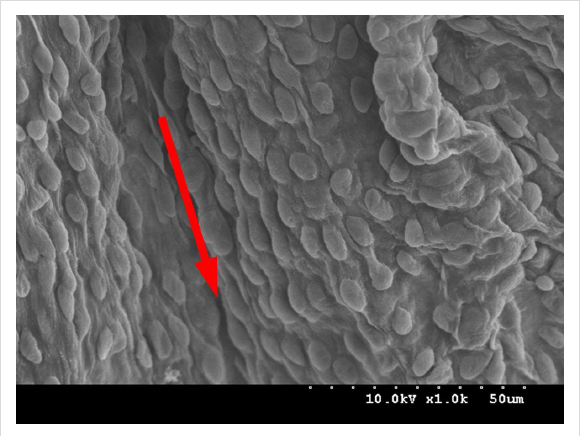
Figure 6: The direction of aligned “cobblestones” on the mitral valve leaflet’s